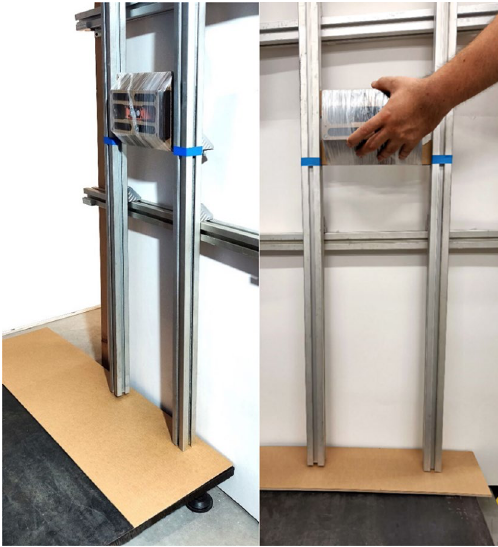
Fig. 3 Modified drop test with vertical guideways for the